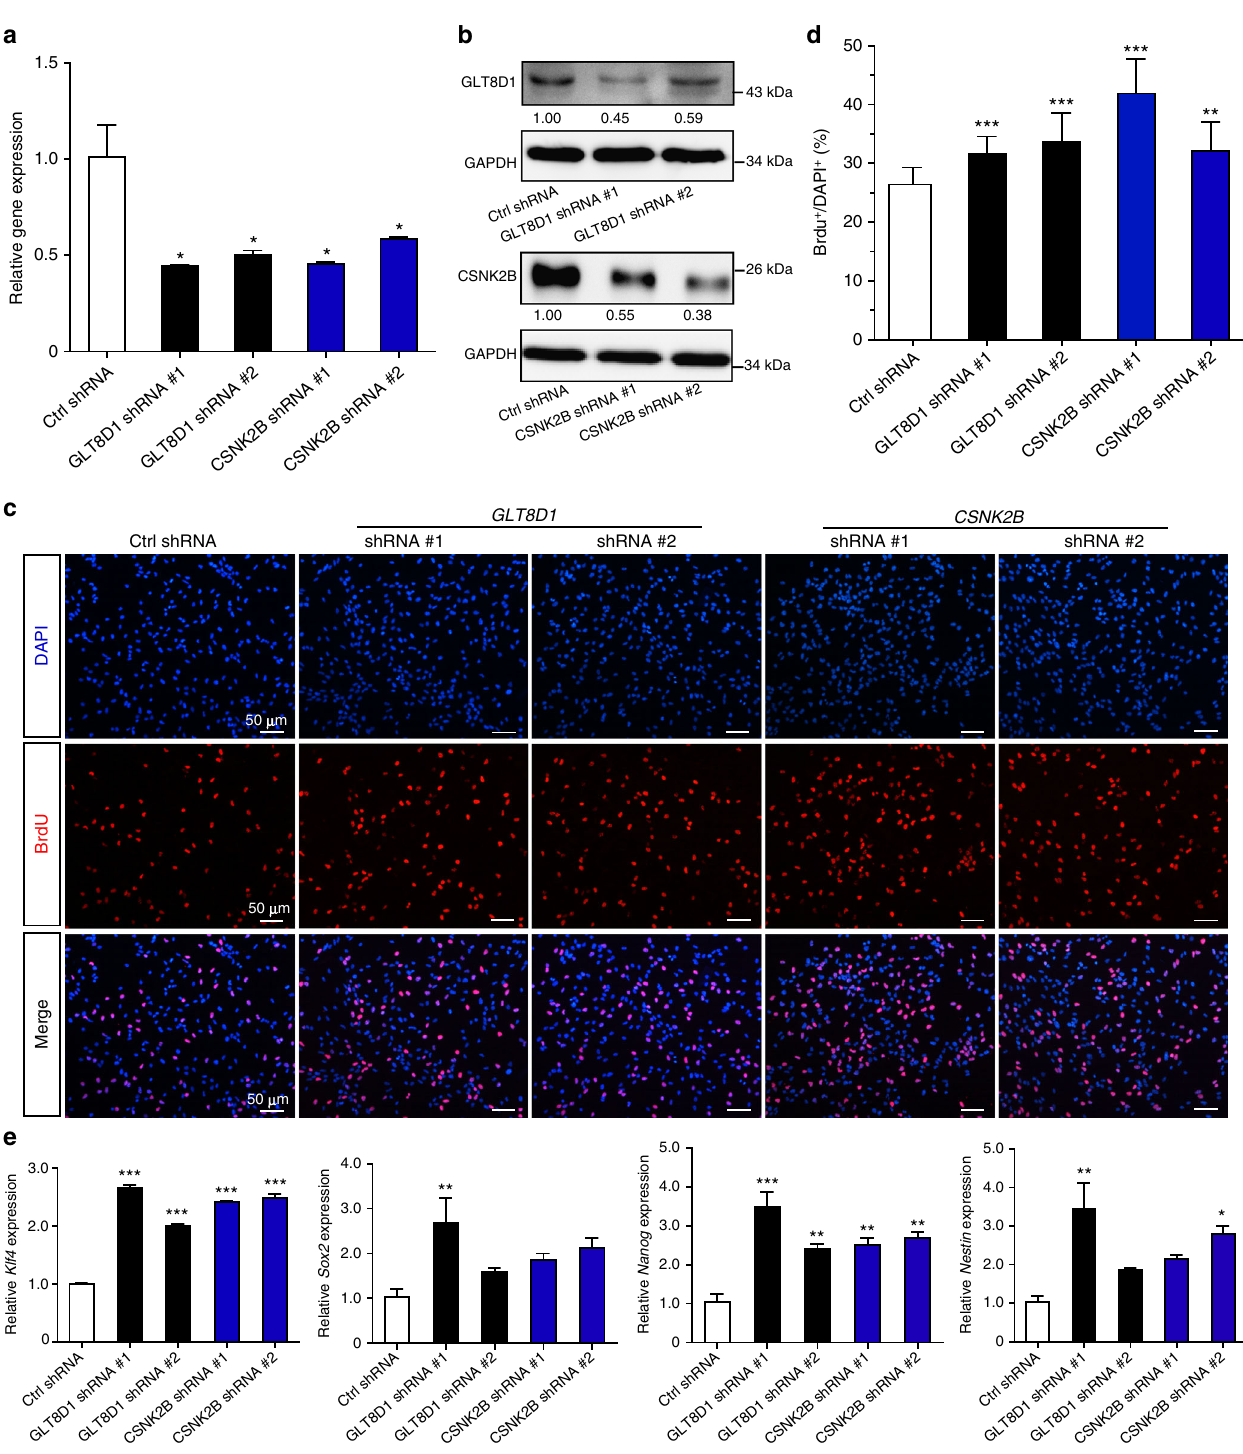
Fig. 3 Knockdown of GLT8D1 and CSNK2B promote NSCs proliferation and upregulate the expression of the stemness marker genes. a Real-time PCR showed that the shRNAs signi fi cantly reduced the mRNA expression level of GLT8D1 and CSNK2B in NSCs. b Western blotting showed that protein level of GLT8D1 and CSNK2B was also signi fi cantly reduced. c , d Knockdown of GLT8D1 and CSNK2B promote the proliferation ability of NSCs by BrdU incorporation assay. d The quanti fi cation data for c . e Knockdown of GLT8D1 and CSNK2B increased the expression of stemness ( Sox2 , Klf4 , Nanog , and Nestin ) marker genes signi fi cantly. GAPDH was used an internal control. * P < 0.05, ** P < 0.01, *** P < 0.001, two-tailed Student ’ s t -test. Data represent mean ± SD from three independent biological